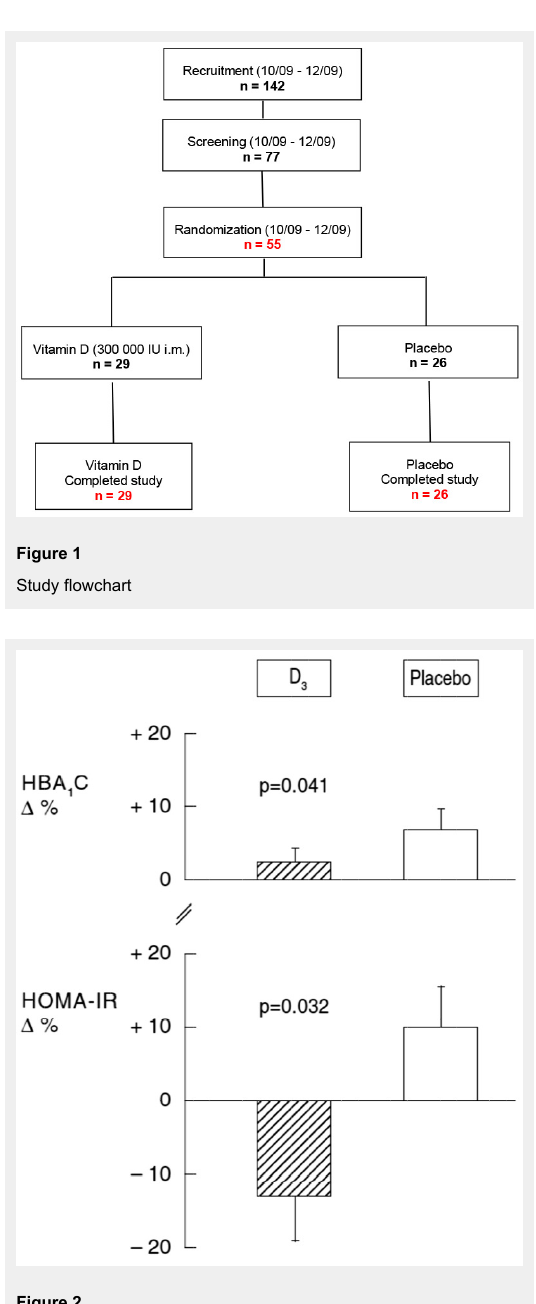
Effect of D 3 supplementation on the percent changes in HbA 1c and HOMA-IR. HbA 1c = glycosylated haemoglobin; HOMA-IR = homeostasis model assessment insulin